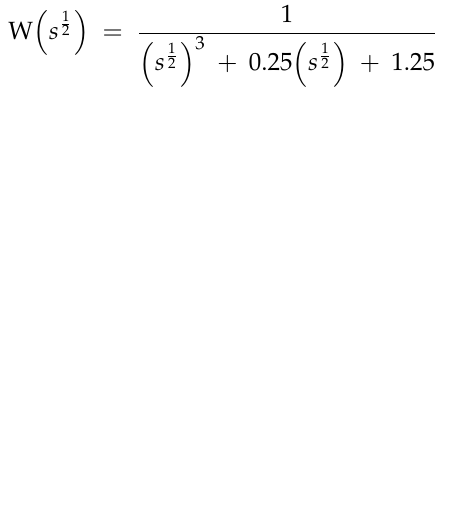
Figure 11. The transition function in this